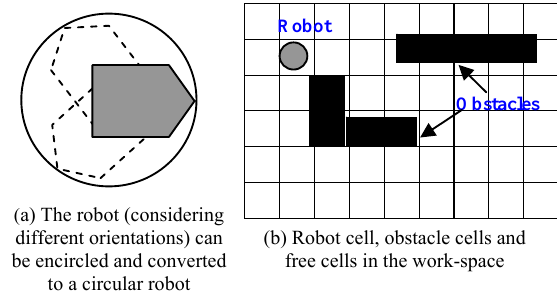
Fig 2. Decomposition of the workspace and constructing cellular autamata